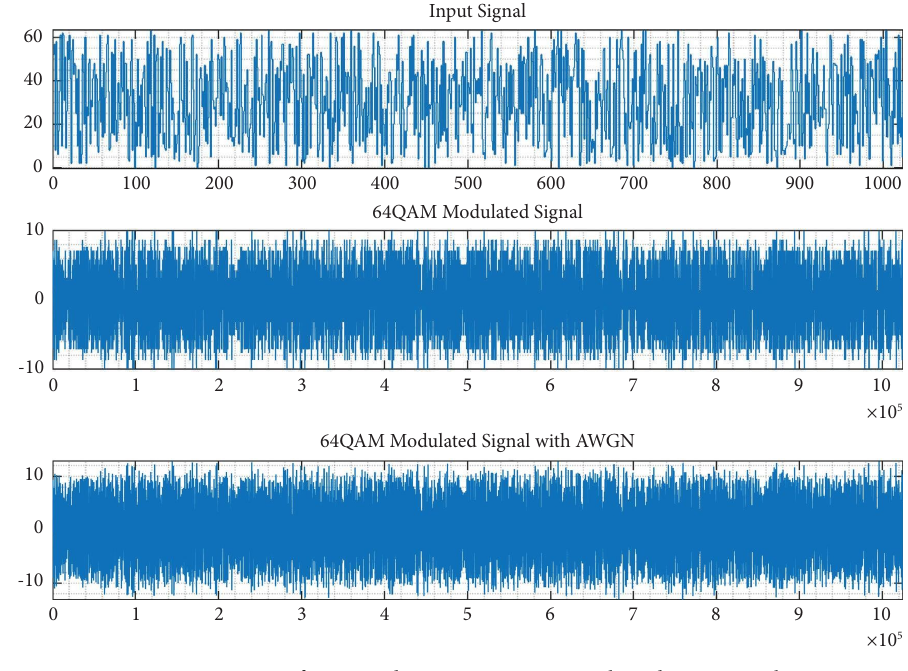
Figure 8: Status of generated 64QAM-OFDM signals and input signals.